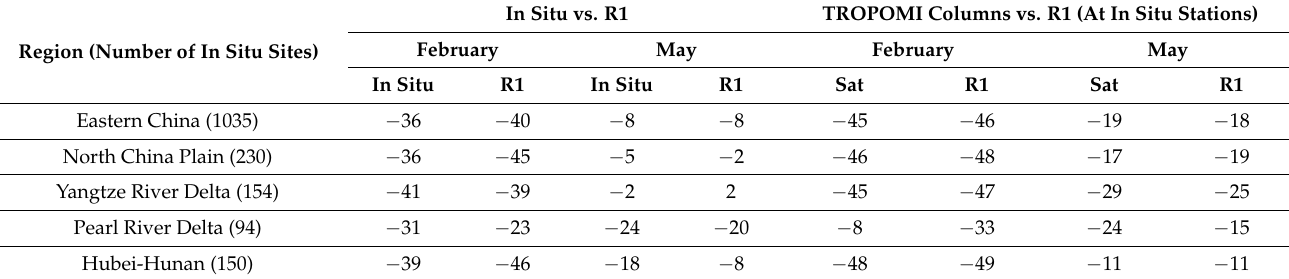
Table 3. Percentage changes between 2019 and 2020 in: (i) NO 2 surface concentrations modeled by the standard simulation (R1) and observed at network in situ measurement stations (Figure A1), and (ii) NO 2 columns modeled by R1 and observed by TROPOMI at the locations of the in situ observations. All values are calculated for the regions shown in Figure 4. The number of measurement stations is indicated for each region between